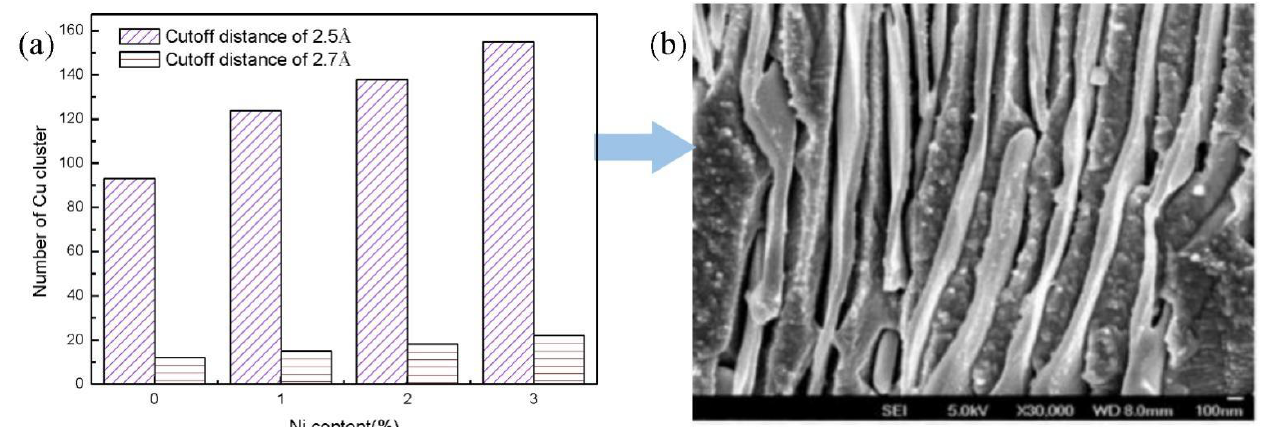
Figure 13. The results of clusters for: ( a ) number of clusters with different cutoff distances; ( b ) the growing lamellar precipitates with excessive Ni element.